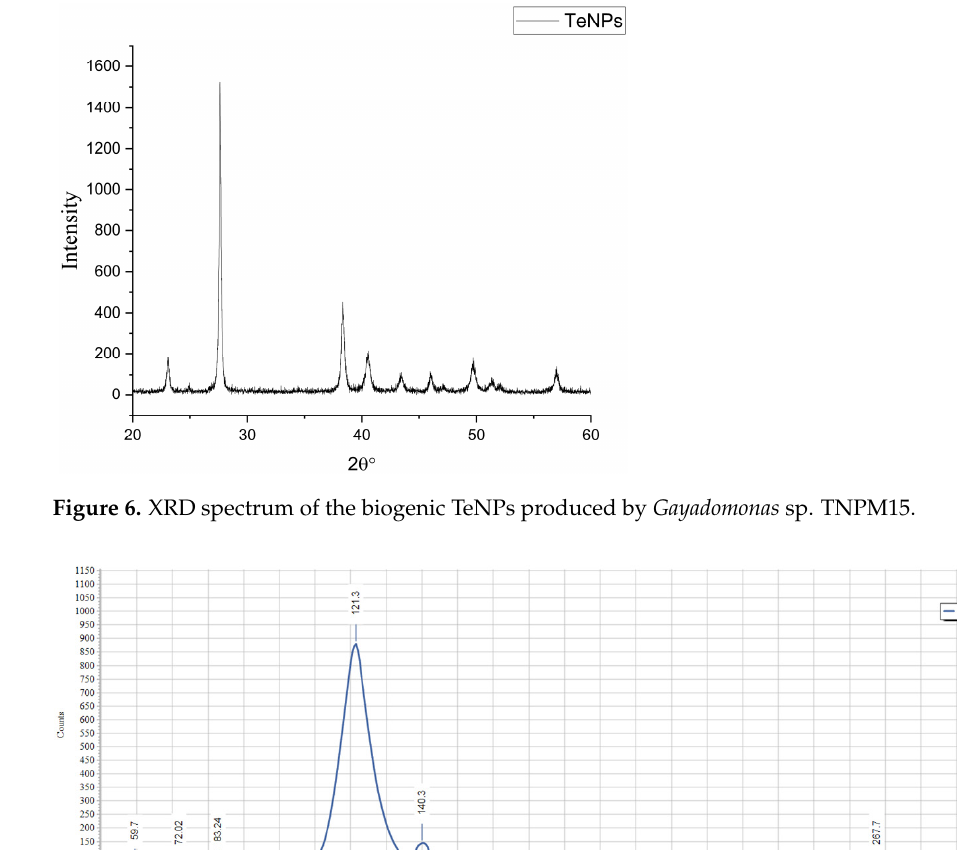
Figure 5. EDX spectrum of the biogenic TeNPs produced by Gayadomonas sp. TNPM15.